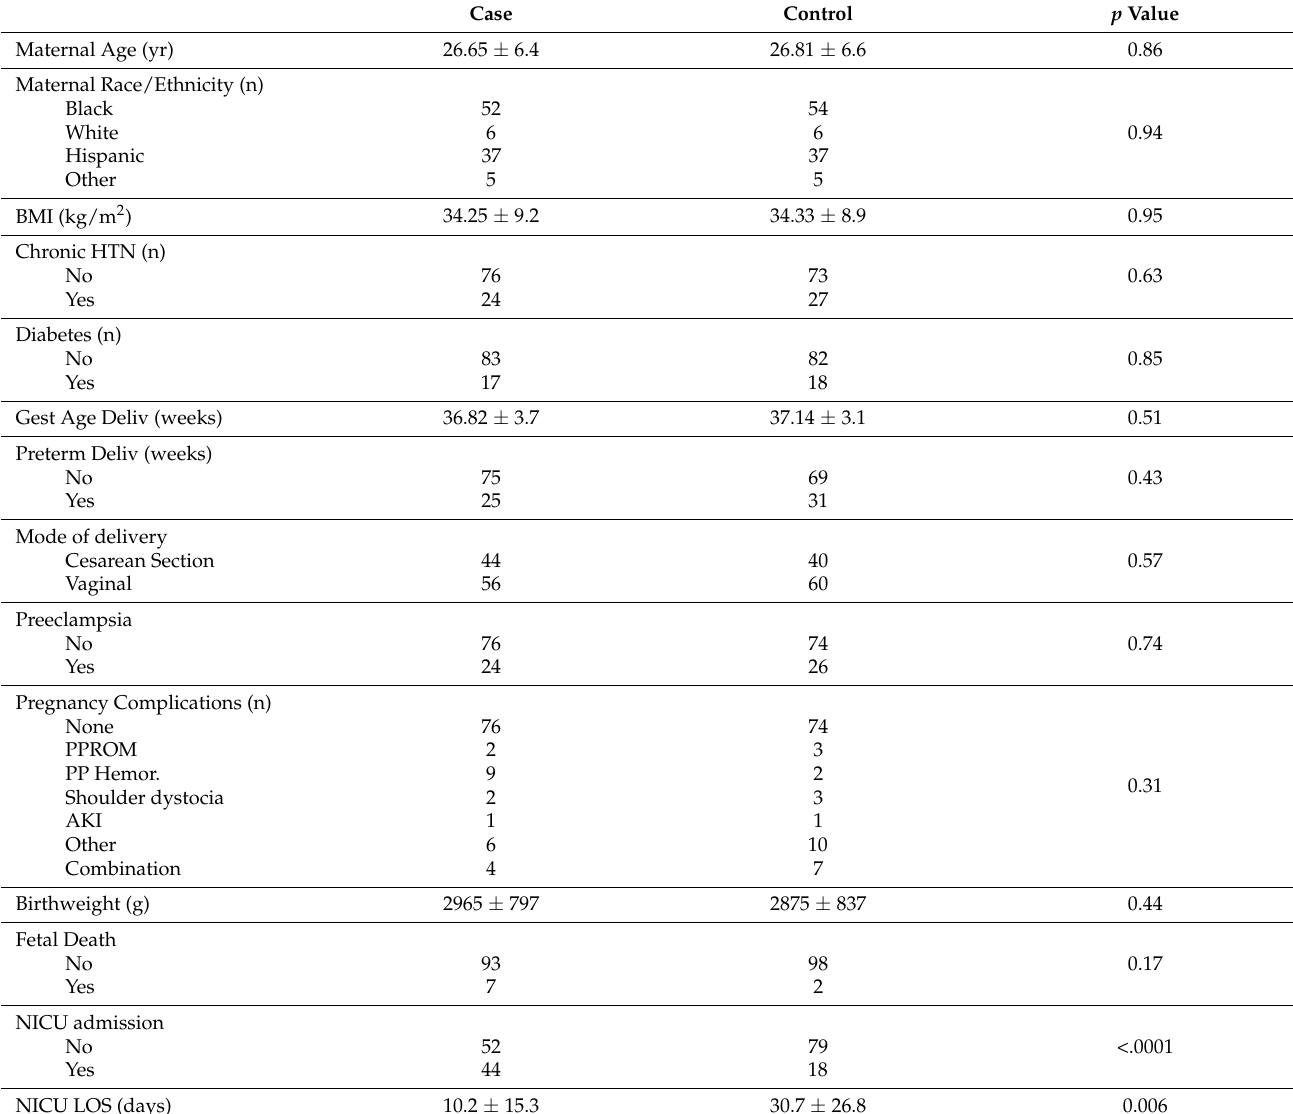
Table 2. Characteristics of pregnant women with and without